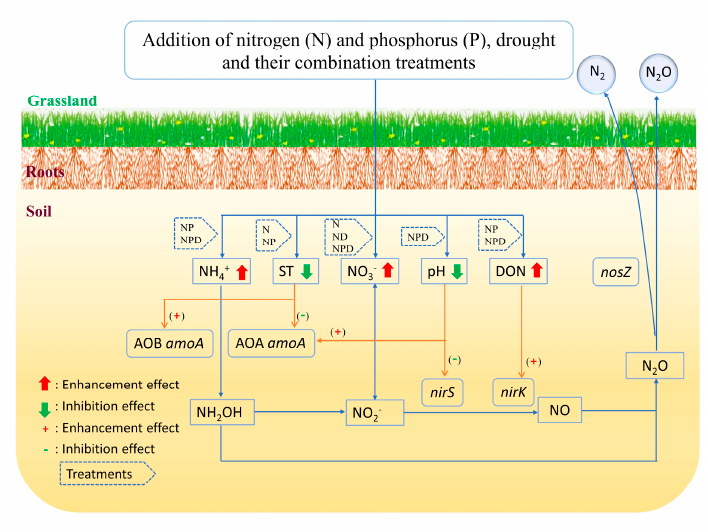
Figure 6. Conceptual diagram of gene abundance response to N addition, P addition, drought, and their combination. Note: NH 4+ (mg/kg): NH 4+ -N content; ST (°C): soil temperature; NH 3 − (mg/kg): NO 3 − -N content; DON (mg/kg): dissolved organic nitrogen.